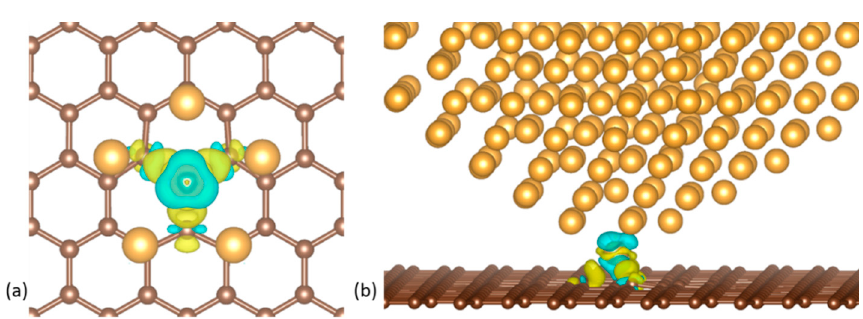
Figure 7. ( a ) Top and ( b ) side views of the charge density difference of a decahedral Au 561 nanocluster with a vertex on a graphene vacancy. Blue and yellow colors represent charge depletion and accumulation, respectively.